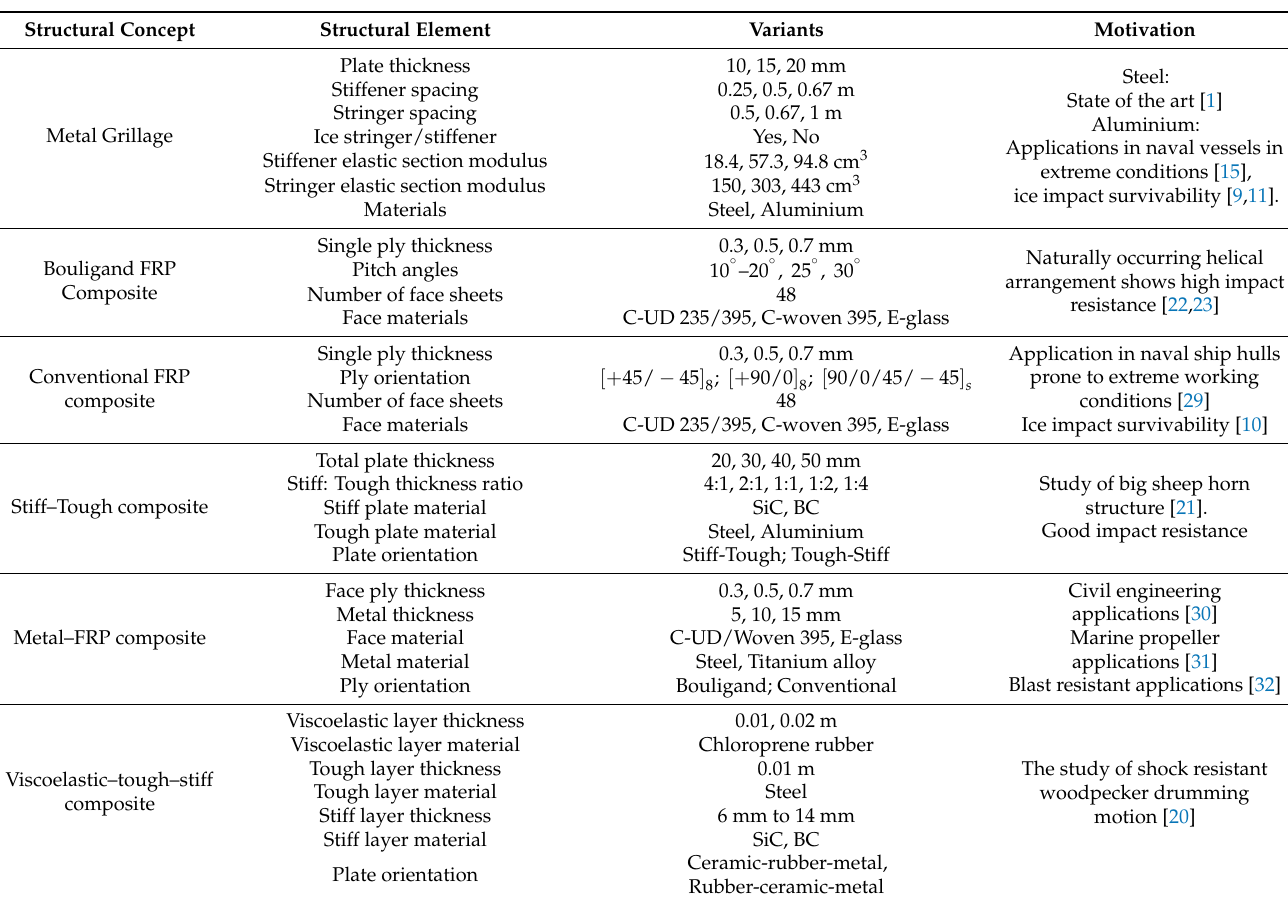
Table 1. Structural candidates and their parametrization. The term ‘ice stringer / ice stiffener’ refer to members that are directly present underneath the impact